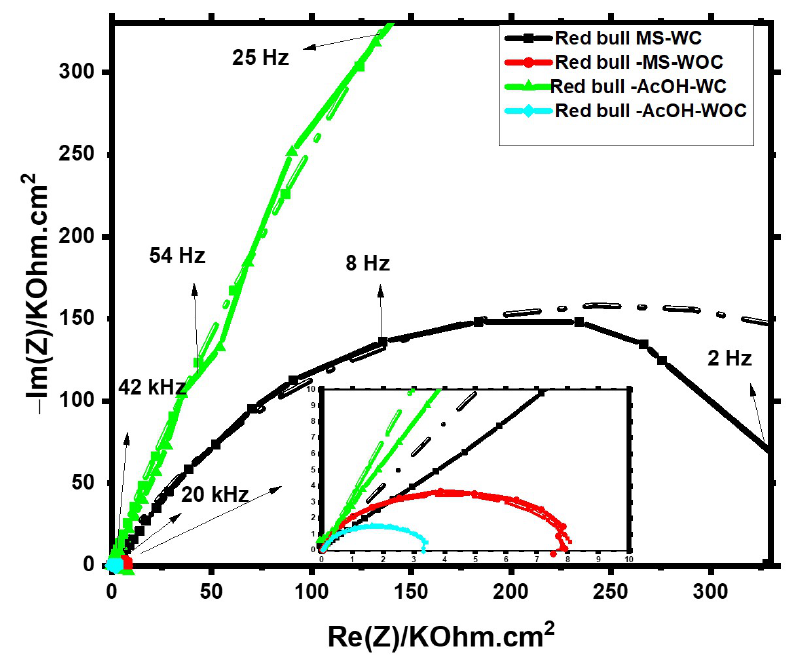
Figure 4. The Nyquist diagram for the Red Bull samples in main and acetic acid [0.1 M] solutions with (WC) and without (WOC) an organic coating; dash dot lines represent fitting according to Figure 5.